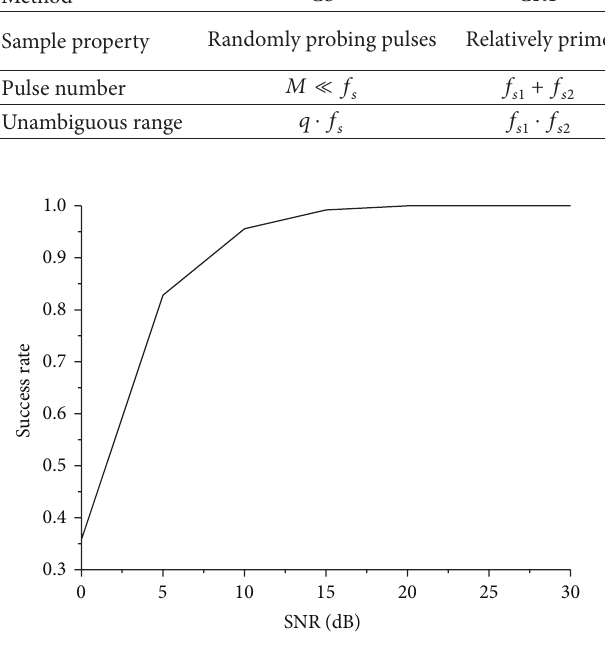
Figure 4: The success rate of reconstruction at different SNR.